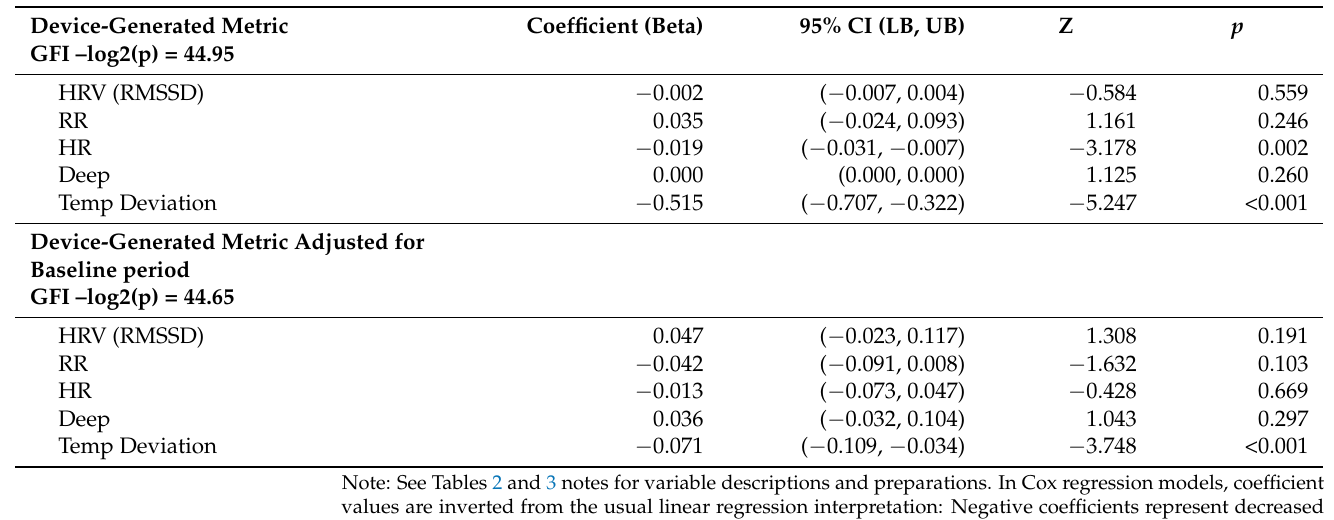
Table 5. Multivariate regression models predicting RBD antibody responses from device-generated metrics before and after adjusting for the pre-vaccination baseline period that demonstrated associa- tions with RBD antibody responses in Spearman correlations from night 0 after the second injection for Moderna-NIAID and Pfizer-BioNTech vaccine recipients,